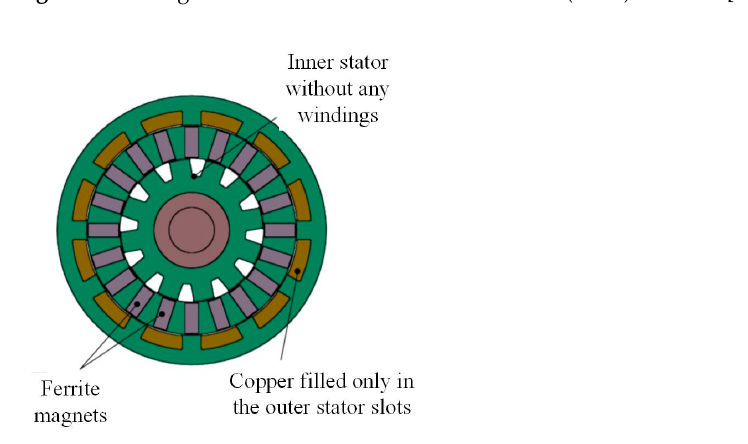
Figure 17. Configuration of a double stator VPM machine without inner stator winding [42].